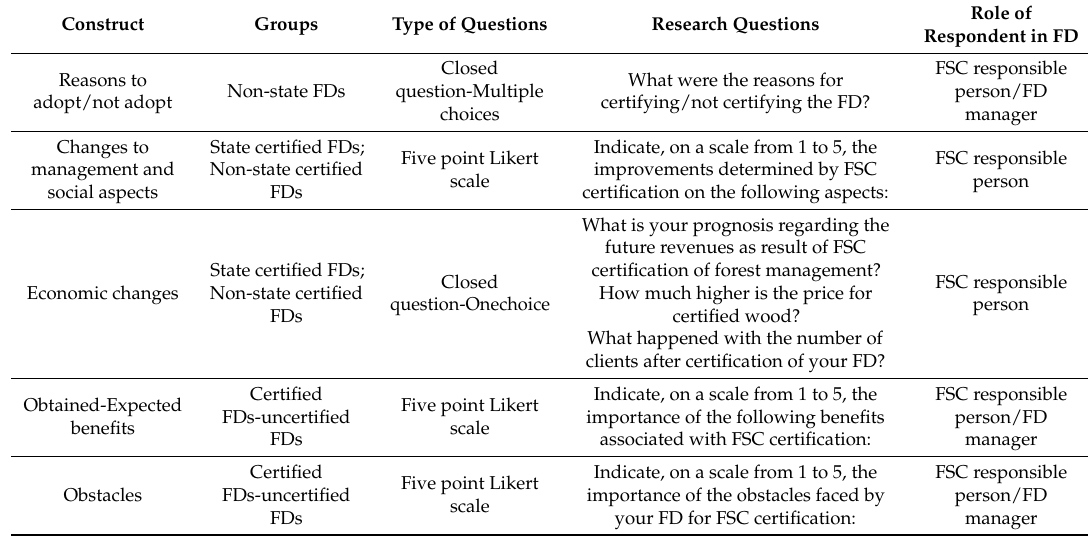
Table 1. Constructs used in the